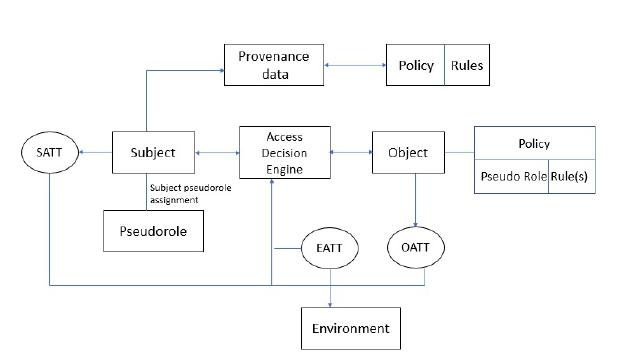
Figure 3. Policy Structure